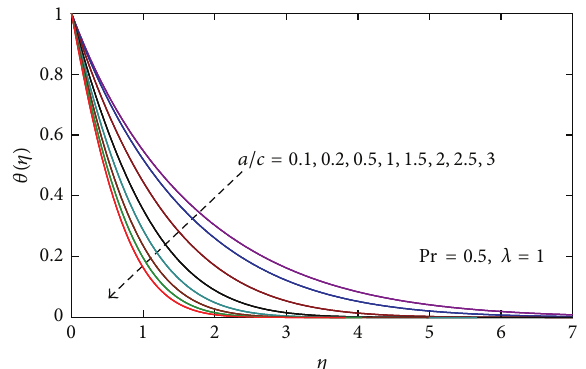
Figure 2: Velocity profiles 𝑓 󸀠 (𝜂) for various values of 𝑎/𝑐 .